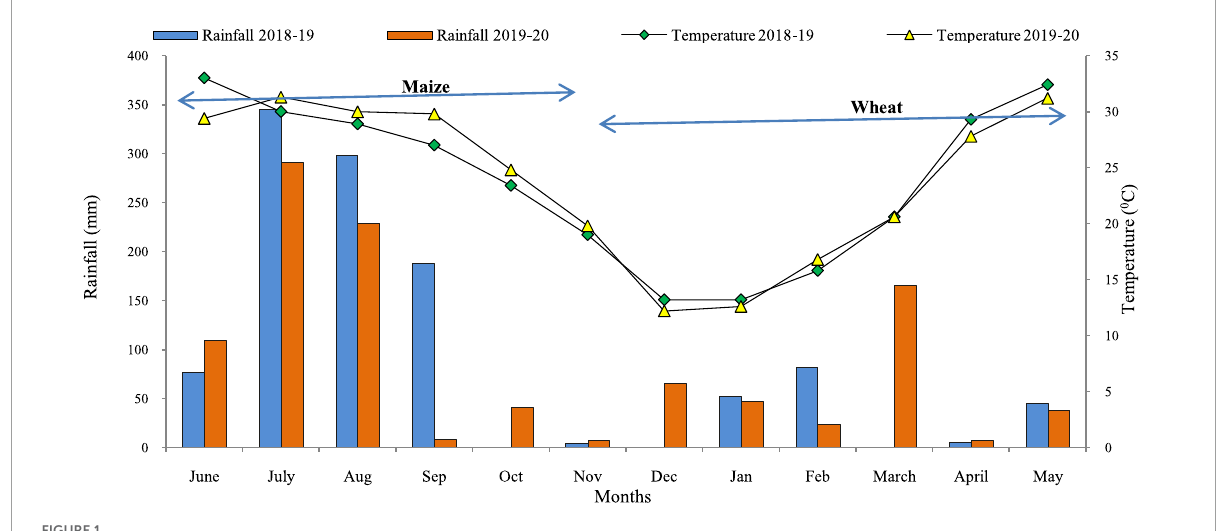
FIGURE1 Monthly rainfall and mean temperature during crop growing seasons (2018–2020). Source: Agro-meteorological observatory, Division of Agricultural Physics, ICAR-IARI, New